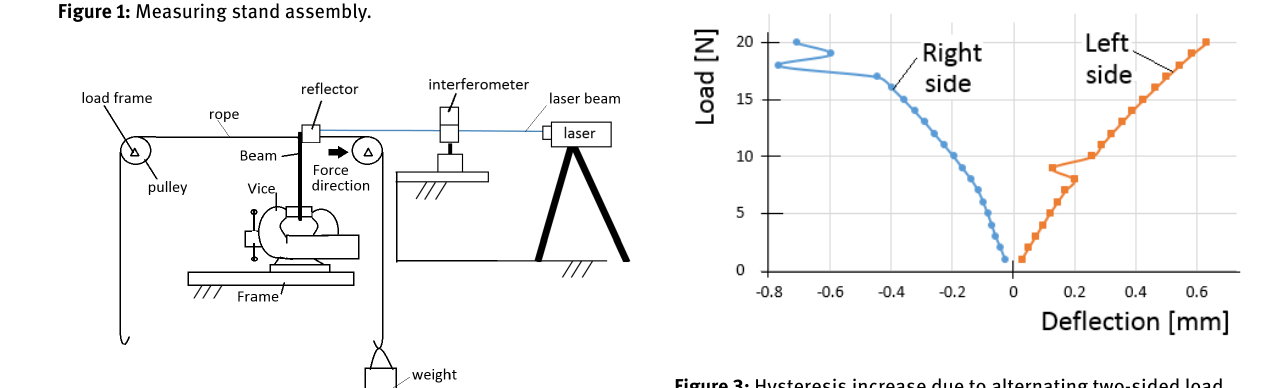
Figure 1: Measuring stand assembly.